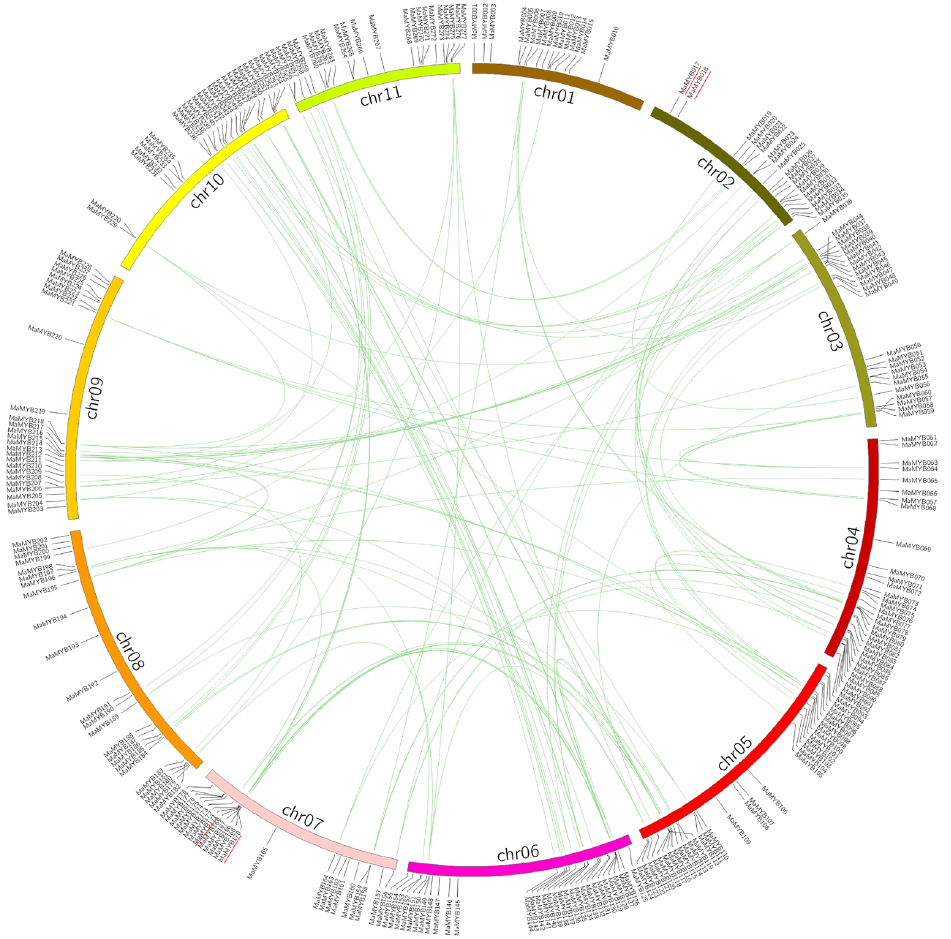
Figure 3. Distribution and synteny analysis of MaMYBs on the 11 chromosomes of the Musa acuminata genome. The locations of the MaMYBs are indicated by vertical black lines. The segmental duplicate MaMYBs are connected with green lines, and red lines indicates tandem duplicated MaMYBs